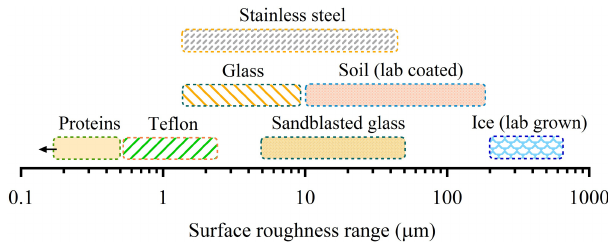
Figure 1. Typical surface roughness for materials commonly used in flow tube gas uptake and kinetic experiments. Data sources are https://neutrium.net/fluid_flow/absolute-roughness/ and http:// www.edstech.com/design-tools.html. The soil roughness refers to Li et al. (2016) and the ice roughness refers to Onstott et al. (2013) and Landy et al.